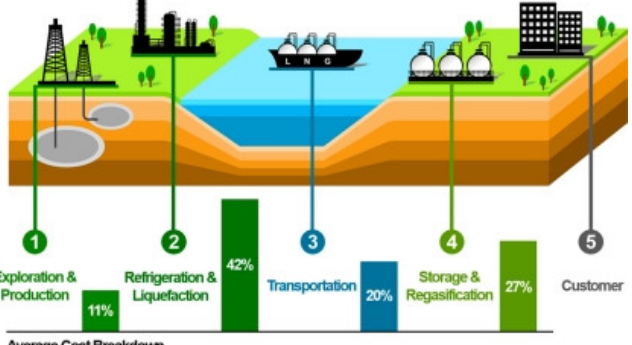
Figure 2. LNG value chain and the cost breakdown [14]. Reprinted (adapted) with permission